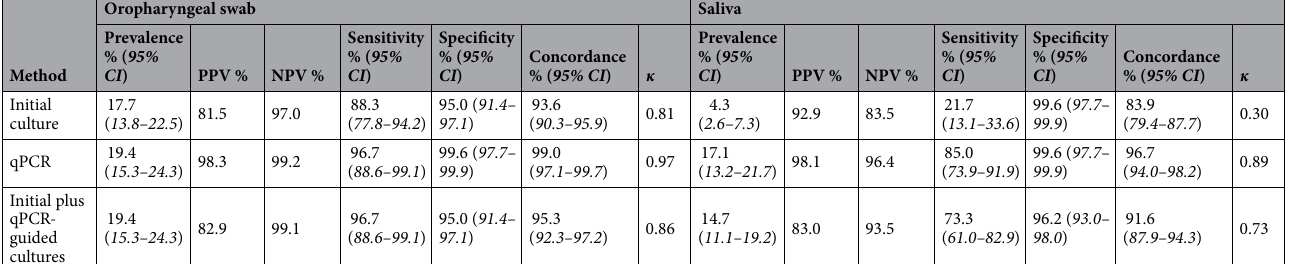
C T cut-off values by using the Youden index (Table S4). Using qPCR detection we identified 61 students (20% of 299) as a meningococcal carrier. The difference in proportion of carriers detected by qPCR between oropharyn- geal samples and saliva samples was not significant (59 or 20% vs. 52 or 17%, McNemar’s test; p = 0.0704), both methods showed high agreement (96%; κ 0.88). Samples classified as positive for meningococcus by qPCR dis- played significant correlation between metA and ctrA , supporting high specificity of molecular detection (Fig. 2). Detection by culture and by qPCR resulted in 71 (24% of 299) and 62 (21%) students identified as a meningococ- cal carrier in oropharyngeal and saliva samples, respectively. Altogether 74 (25%) students were identified as a meningococcal carrier and 62 (21%) as carrier of genogroupable meningococci by any method used (Fig. 3). When comparing methods and specimen types used for detection of meningococcal carriage overall, all evalu- ated procedures displayed comparable specificity of detection (Table 1) and primarily varied in performance for sensitivity and for positive predictive value (PPV). The criterium based on both ctrA and metA was expected to impact negatively the sensitivity of meningococ- cal carriage detection by qPCR when compared with culture due to the presence of non-genogroupable menin- gococci that were likely to be ctrA -negative. Therefore, we compared methods and specimen types on samples containing genogroupable meningococci (Table 2), which were supposed to be positive for both ctrA and metA . The PPV and sensitivity of the evaluated methods were highest for detection by qPCR, whereas using saliva samples resulted in decreased negative predictive values (NPV) when compared with oropharyngeal samples. Detection of genogroupable meningococci using qPCR and saliva displayed increased PPV and comparable sensitivity when compared with detection of meningococcus in initial oropharyngeal cultures. Next, we determined with genogroup-specific qPCRs the prevalence of genogroup A, B, C, W and Y carriage. The specificity of these qPCR assays was tested using culture-enriched samples negative for meningococcal carriage by culture and qPCR and none of the samples negative for ctrA generated a signal below 25 C T for a genogroup-specific gene (Fig. S1). Altogether, 51 (83.6%) of 61 students identified as carriers of meningococci with qPCR were positive for any of the genogroups targeted in group-specific qPCRs (Fig. 4). Genogroup-specific